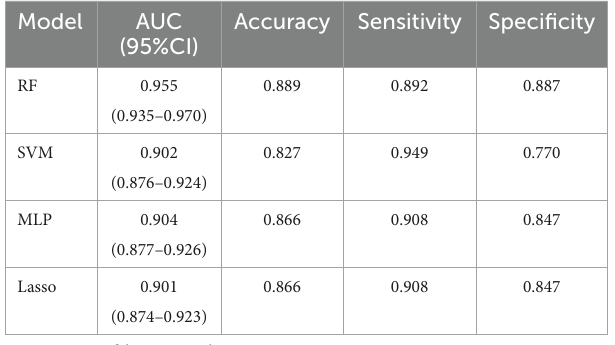
95%CI, 95% confidence interval.